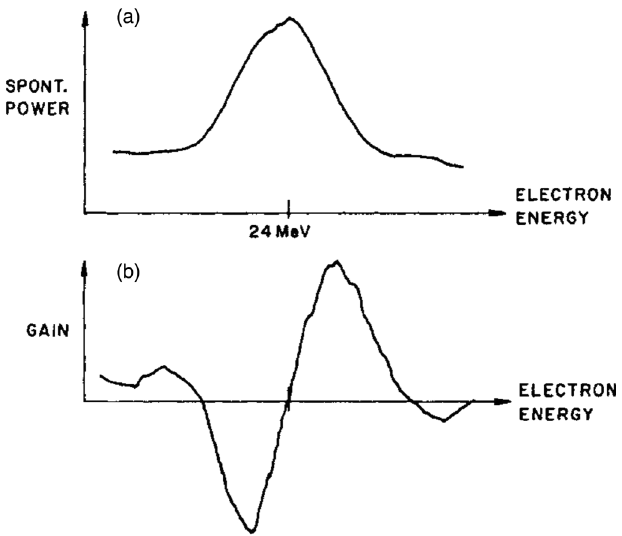
FIG. 5. Comparison of the measured spectrum of the 10 . 6 μ m spontaneous radiation emitted by the 24 MeV electrons in the amplifier experiment (a) with the gain measured using the setup of Fig.